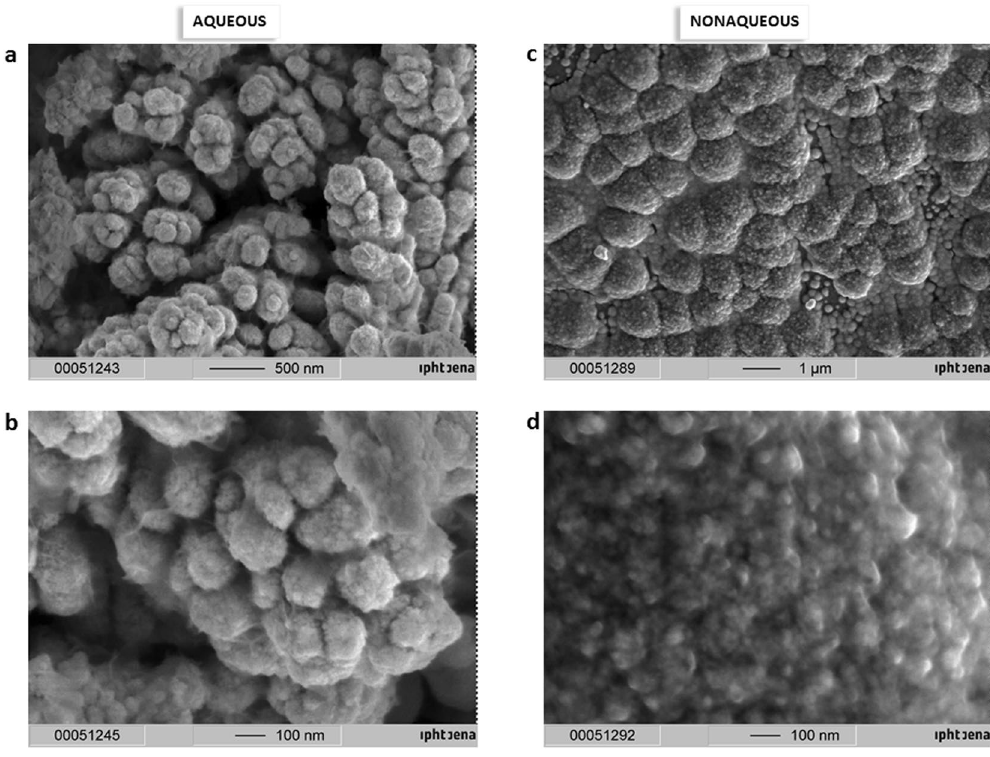
Figure 4. SEM of electrosynthesized platinum black layer on copper: ( a ) in aqueous, ( b ) in non-aqueous (isopropanol)